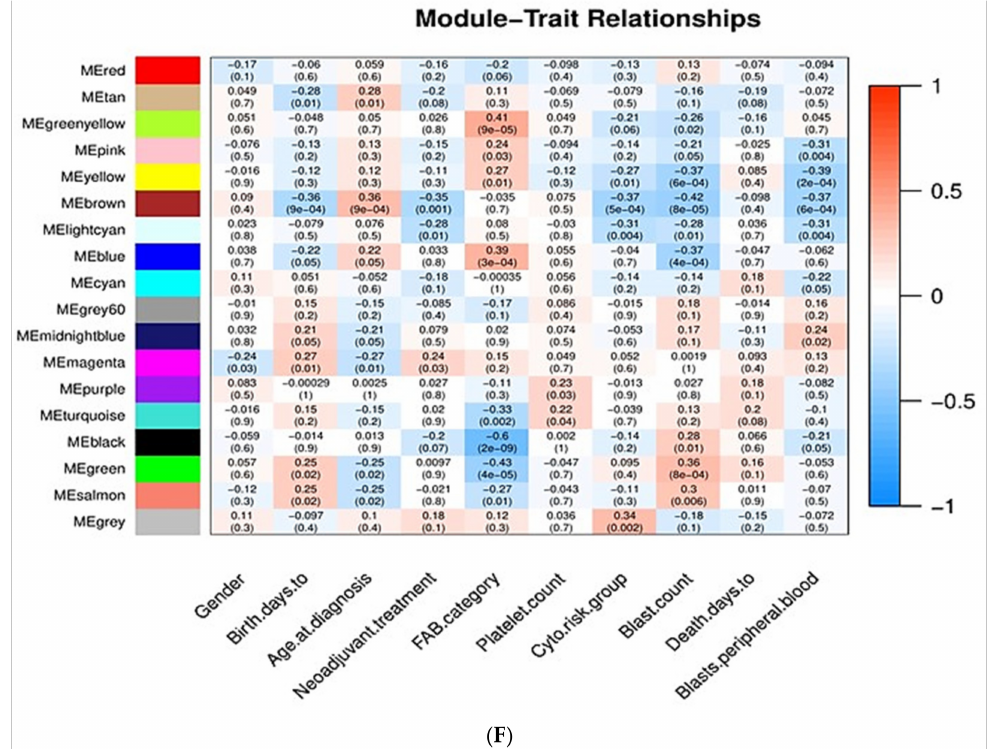
Figure 3. Sample clustering and module detection in WGCNA. ( A ) Sample dendrogram and trait heatmap for detecting outliers. The clustering was based on the expression data of the 3794 DEGs of the AML samples. All 84 samples are located within clusters. Darker shades of red indicate stronger positive correlation, whereas lighter shades of red denote weaker correlation. ( B , C ) Selection of soft-thresholding power ( β ) based on scale-free fit index and mean connectivity for various soft-thresholding powers. ( D ) Clustering of module eigengenes. The red line indicates cutoff height of 0.25. ( E ) Dendrogram of DEGs produced by hierarchical clustering based on dissTOM (1-TOM). Modules are represented by different colors. The two colored rows below the dendrogram represent the original and merged modules. ( F ) Module–trait correlation heatmap for AML clinical traits and gene module eigengenes. Each cell contains the Pearson correlation coefficient and p value. Blue indicates negative correlation, red denotes positive